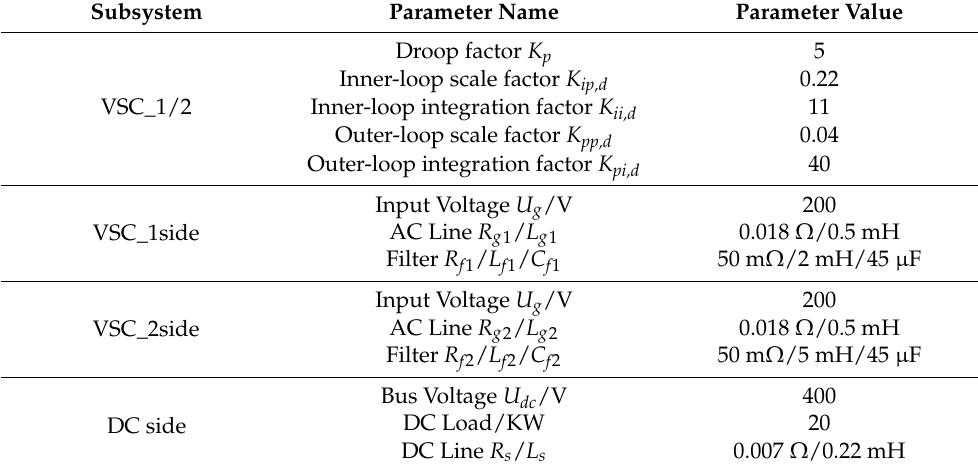
Table 1. System parameters of DC distribution network with two parallel converters.